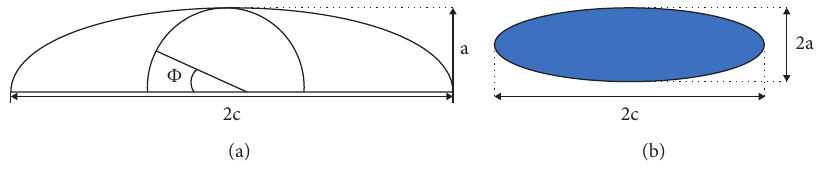
Figure 7: (a) Crack geometry details. (b) Geometric definition of surface cracks ( a � crack depth; c � crack length) used in XFEM fracture analysis.